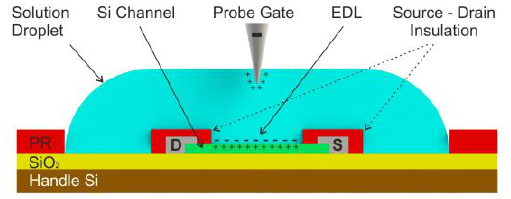
Figure 1. Operation principle of the WG-FET